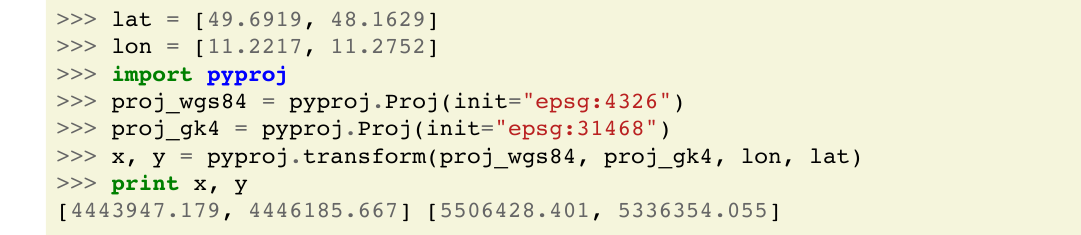
Figure 1. Example code: Conversion of coordinate information using the Python package pyproj.